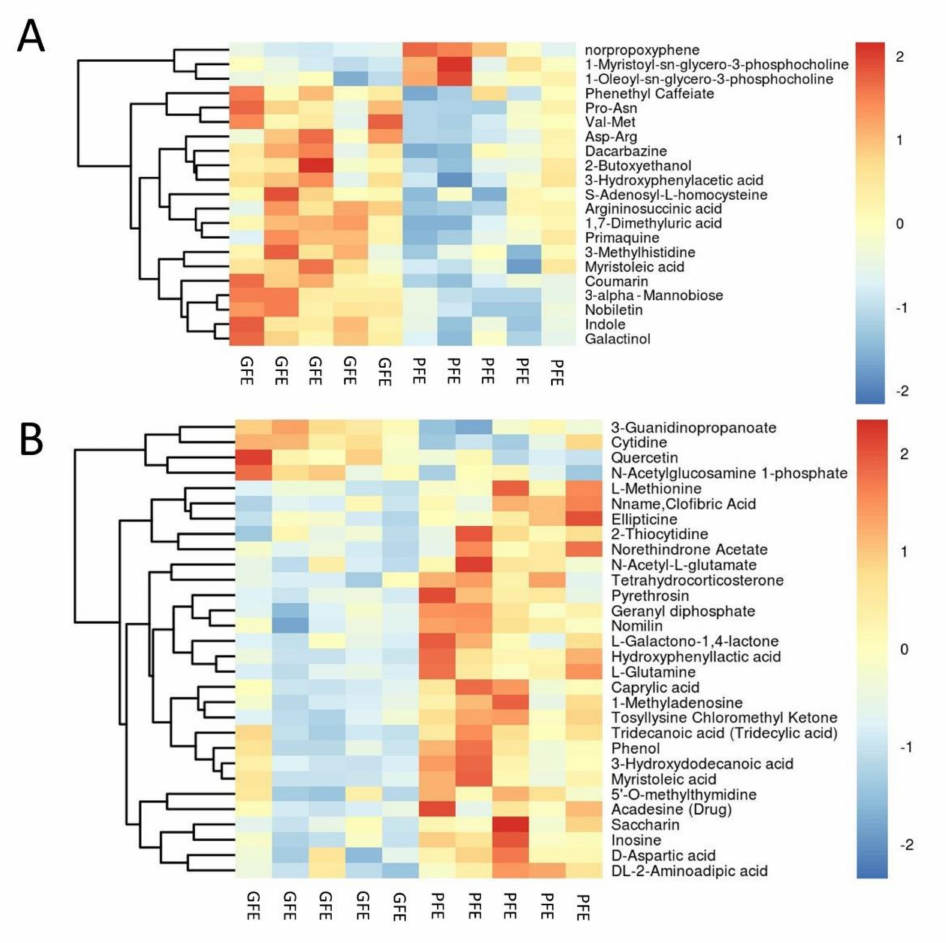
Figure 4. Heat map of metabolites with different content between the GFE and PFE groups. ( A , B ) was analyzed in positive and negative ions mode, respectively.